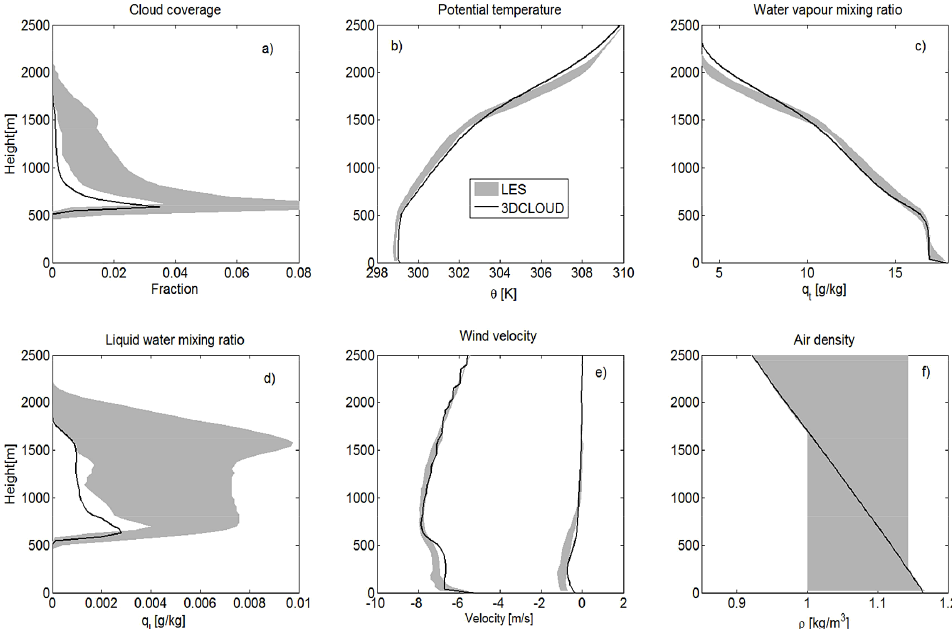
Figure 5. Mean profiles averaged over the fifth hour of (a) cloud coverage, (b) the potential temperature, (c) the water vapour mixing ratio, (d) the liquid water mixing ratio, (e) the horizontal velocity components, and (f) the air density. The BOMEX case is displayed. The solid lines indicate 3DCLOUD results. The light shading delimits the maximum and minimum values within the master ensemble at any given